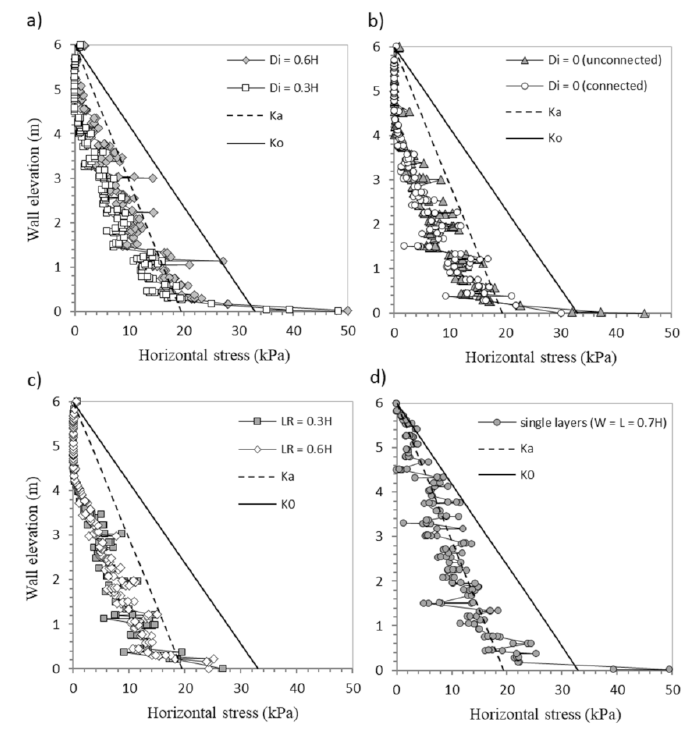
Figure 13. Lateral earth pressure at 1 m from the back of the facing at the end of construction (EoC) for different interaction distances ( D i ) between back-to-back reinforced soil walls: ( a ) D i > 0, ( b ) D i = 0, and ( c , d ) D i <